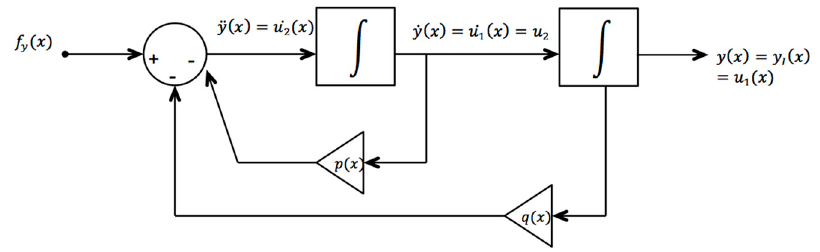
Figure 1. System One representation of linear, second-order, ordinary di ff erential equations, Equation (1) or Equation (6). y I ( x ) indicates a System One output.